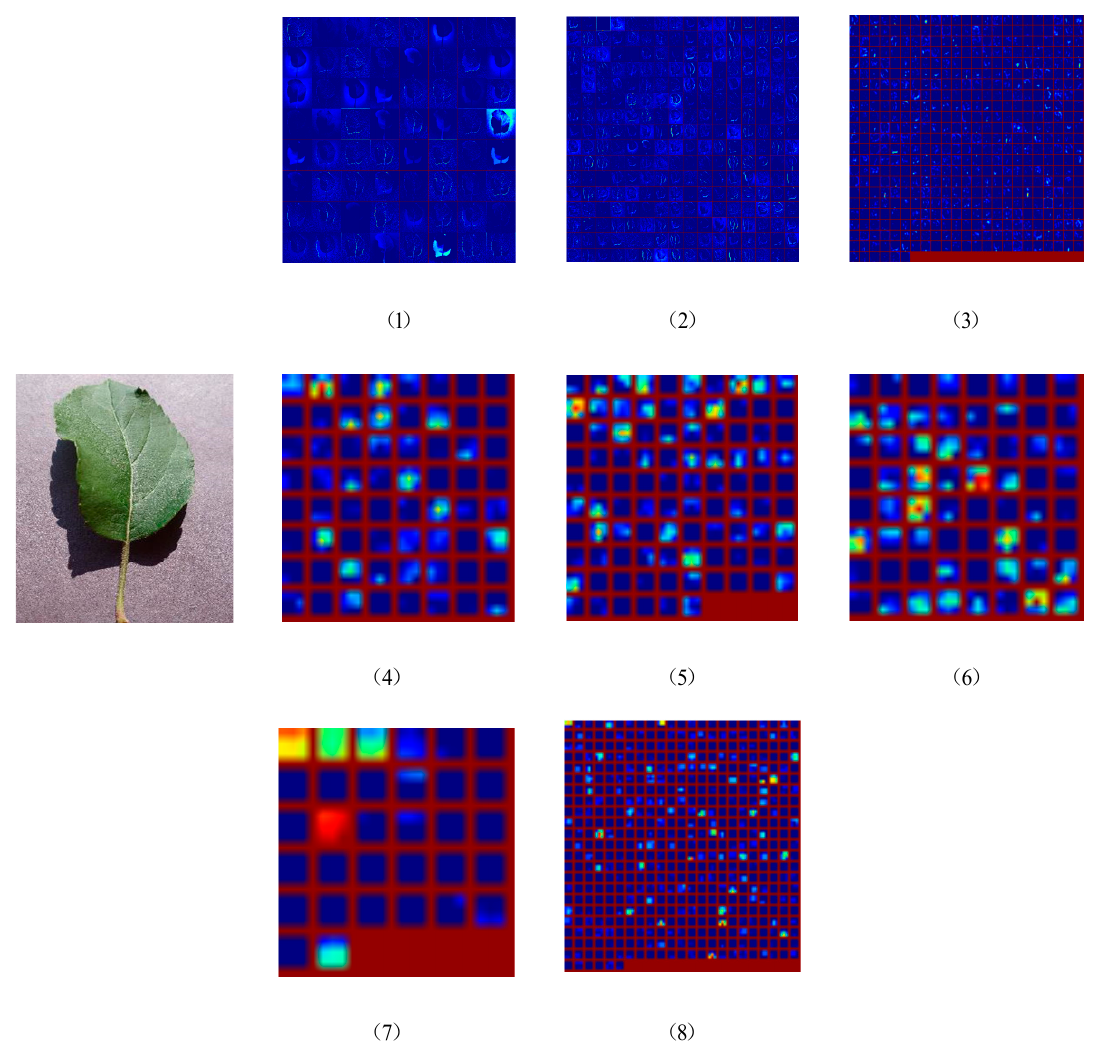
Figure 9. Visualization of feature map from each layer for a sample leaf. ( 1 ) conv1_1 (see Table 2), ( 2 ) conv3_1, ( 3 ) conv5_1, ( 4 ) inception_ 1 × 1, ( 5 ) inception_ 3 × 3, ( 6 ) inception_ 5 × 5, ( 7 ) inception_ pool,